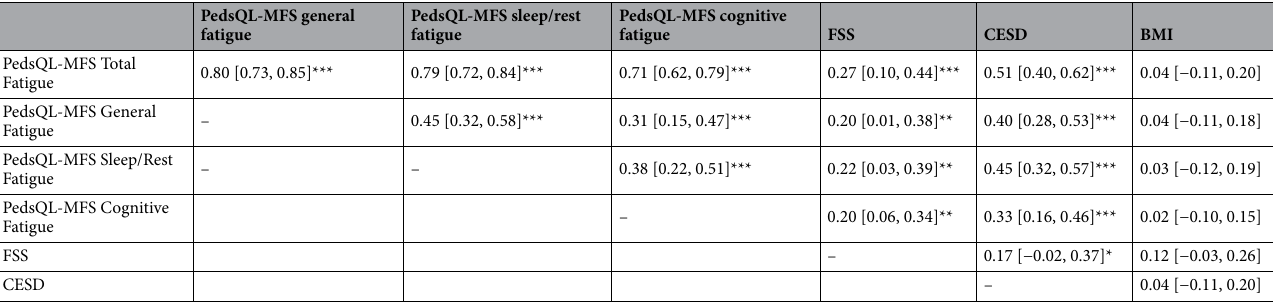
Table 7. Correlations between change scores. * p < .05. ** p < .01. *** p <